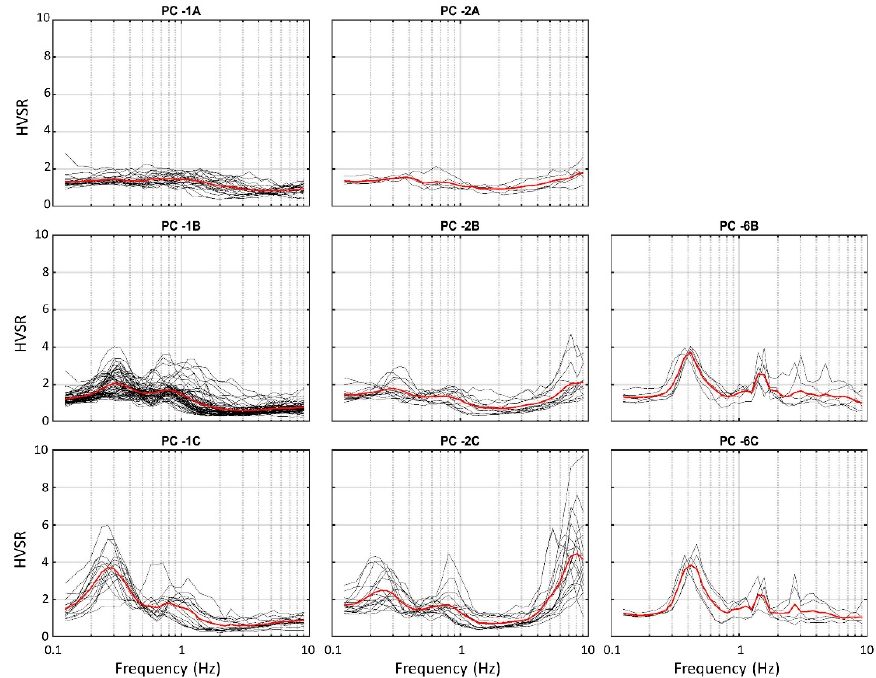
Figure 7. Experimental (black lines) and respective group-average (red lines) curves corresponding to the PC classes characterized by F 0 values in the frequency range of 0.3–0.4 Hz (PC-1, PC-2 and PC-6) by also considering the respective amplitude subclasses (A, B and C). The empty slot in the first row is due to the absence of HVSR curves belonging to subclass A within the PC-6 class. The map in Figure 8 shows the spatial distribution of the identified classes and sub- classes in the study area. A good correlation is observed between the characteristic pat- terns and morphostructural domains. In fact, SFTB and GP domains present a marked prevalence of characteristic patterns with resonance frequencies above 1 Hz (mainly PC+1 lar spatial groupings are evident.